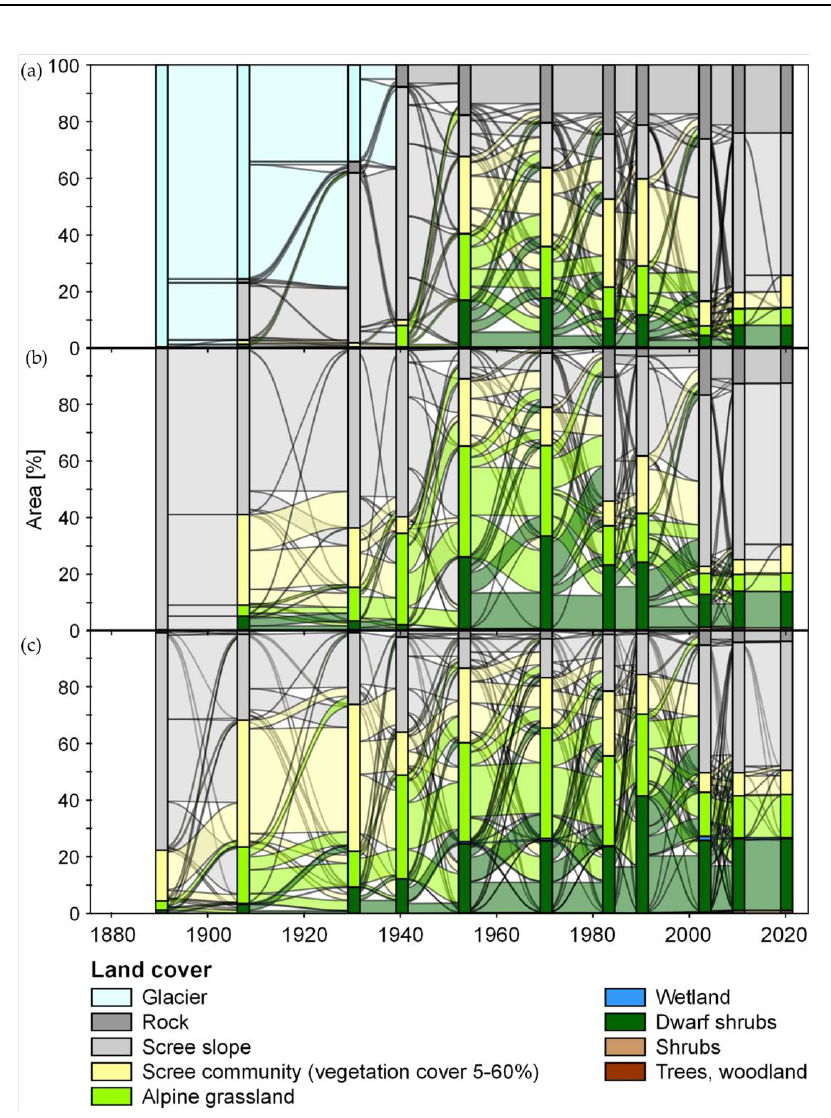
Figure A2. Changes of the land-cover types on in 1890 ( a ) initial glaciated area, ( b ) the initial active area (initial gully system), and ( c ) the initial more stable (not active) area; the different colours indicate the different land-cover types.